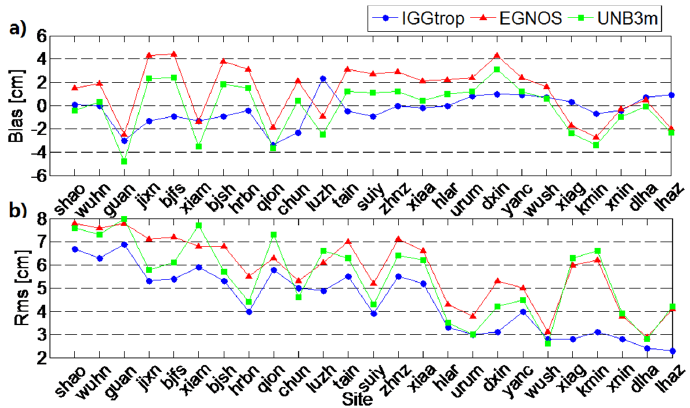
Figure 5. Mean bias ( a ) and RMS ( b ) over the period from 2009 to 2013 for the IGGtrop, EGNOS and UNB3m models. Stations are listed from left to right of the x-axis according to their station height from low to high.